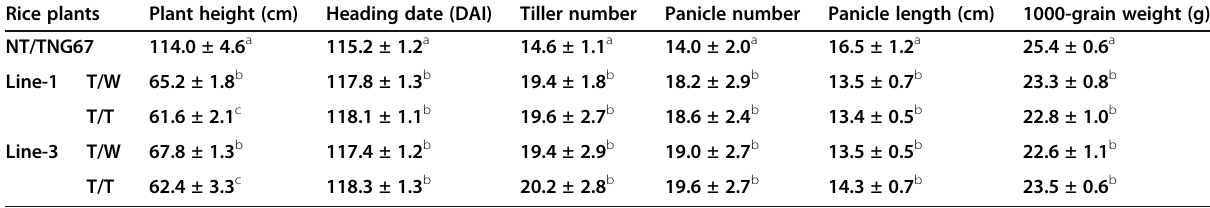
Table 1 Agronomic traits comparisons between OsGA2ox7-OX transgenic lines and NT/TNG67 plants # Rice